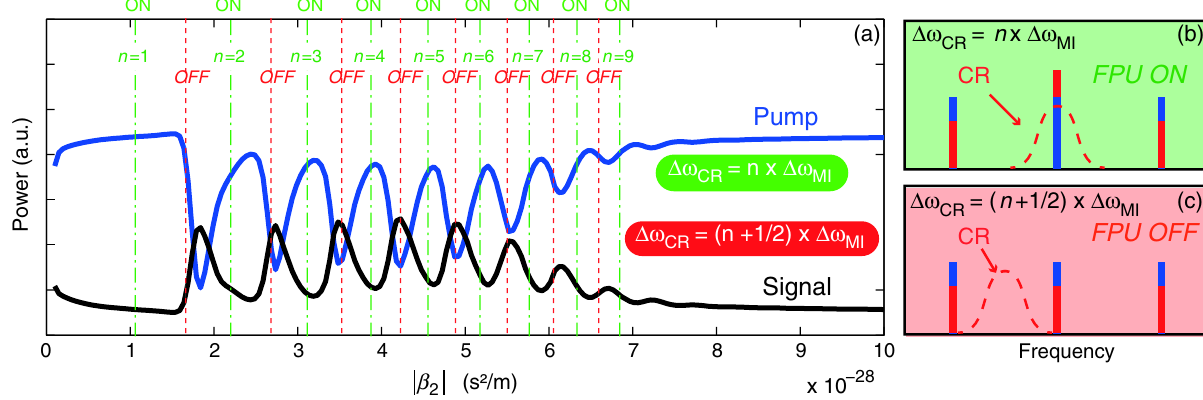
FIG. 3 (a) Evolution of the pump (solid blue curve) and first harmonics (solid black curve) powers versus second-order-dispersion values. Dash-dotted vertical green lines represent the j β 2 j values for which the Cherenkov radiations are exactly located on MI harmonics, while the dotted red lines represent the j β 2 j values when CRs are in the middle between the two harmonics. “ ON ” at the tops of the lines refers to the j β 2 j values for which the FPU recurrence is maximal. (b) The consequence of perfect phase matching between the MI harmonics and CRs. (c) The case of the phase mismatch. In (b) and (c), the dashed curves show the spectra of the CRs. Spectral components shown as blue bars are those before the CR generation, while red bars are those after the CR